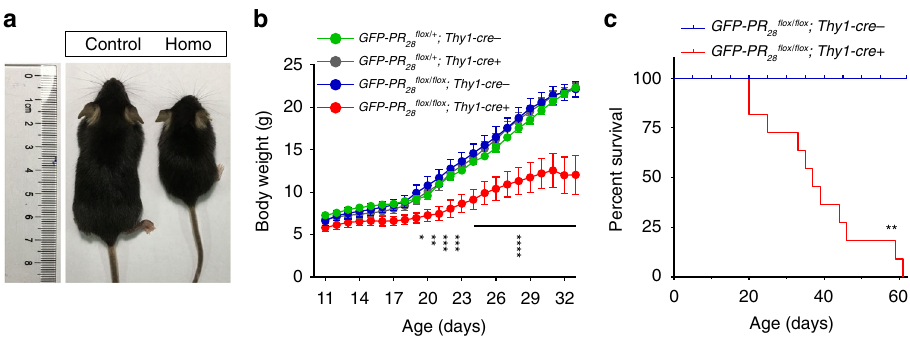
Fig. 2 GFP-PR 28 homozygous mice display reduced body weight and decreased survival. a Representative image showing the body size of the control and homozygous mice at 20 days of age. b Body weight curves of control, heterozygous, and the homozygous mice from postnatal day 11 to 33. Two-way ANOVA, Bonferroni post hoc test; n = 4, 6, 6, 6 mice. c Kaplan – Meier survival curve of the control and homozygous mice. Gehan – Breslow – Wilcoxon test, n = 12, 11 mice. Control: GFP-PR 28 fl ox/ fl ox ;Thy1-Cre- , Homo: GFP-PR 28 fl ox/ fl ox ;Thy1-Cre + ( c ). All data are displayed as mean ± s.e.m. * P < 0.05, ** P < 0.01, *** P < 0.001, **** P < 0.0001